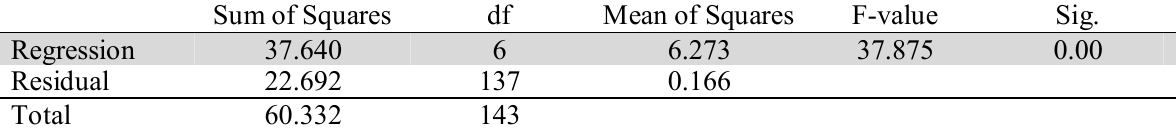
The summary of ANOVA test for testing the second hypothesis